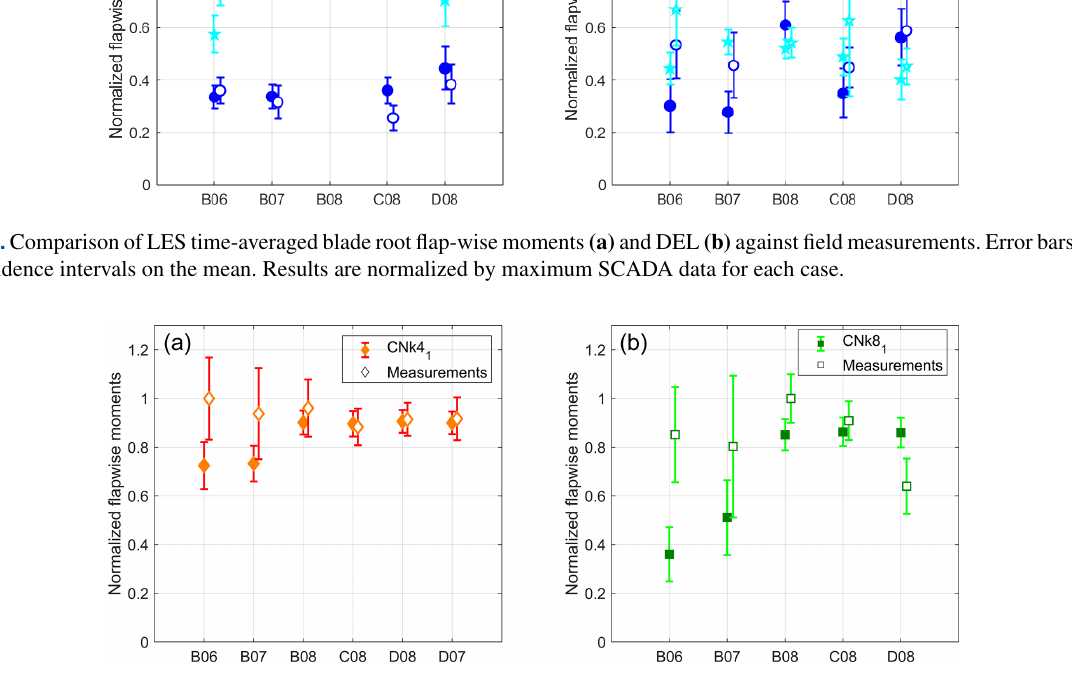
Figure 18. Comparison of LES time-averaged blade root flap-wise moments for (a) CNk4 1 (b) CNk8 1 against field measurements. Error bars represent 95% confidence intervals on the mean. Results are normalized by maximum SCADA data for each